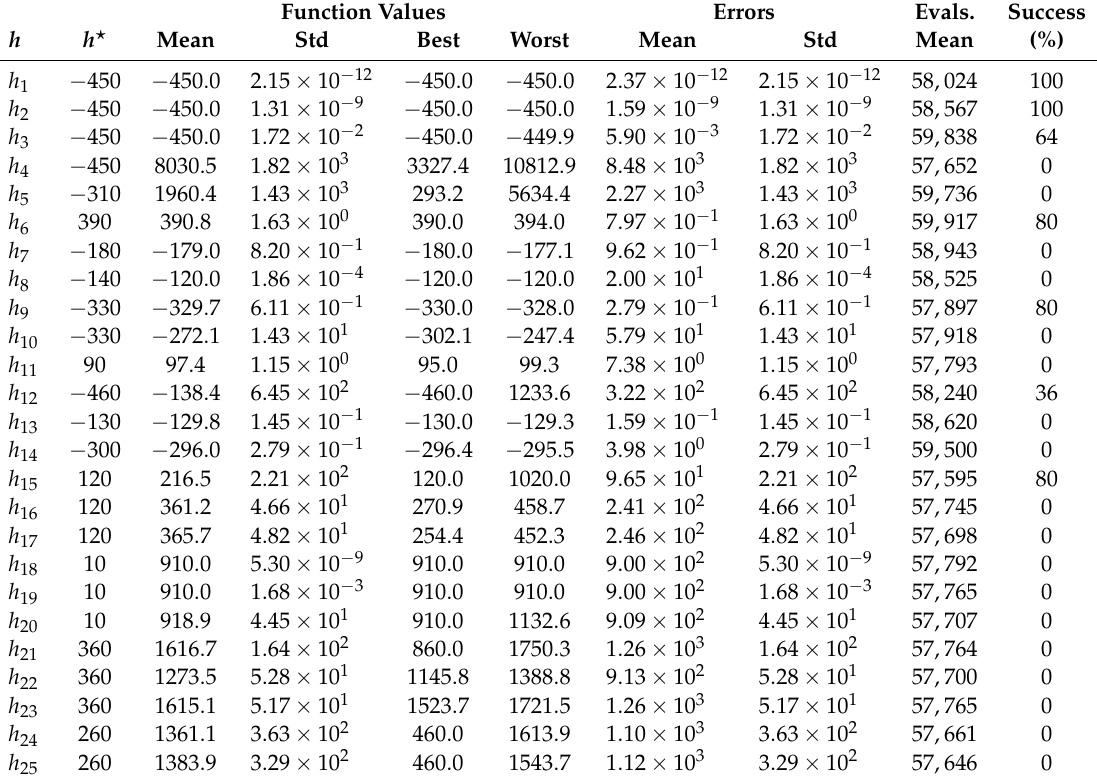
Table 7. The QCGA results of hard functions h 1 – h 25 with dimension n = 10. Function Values Errors Evals. Success